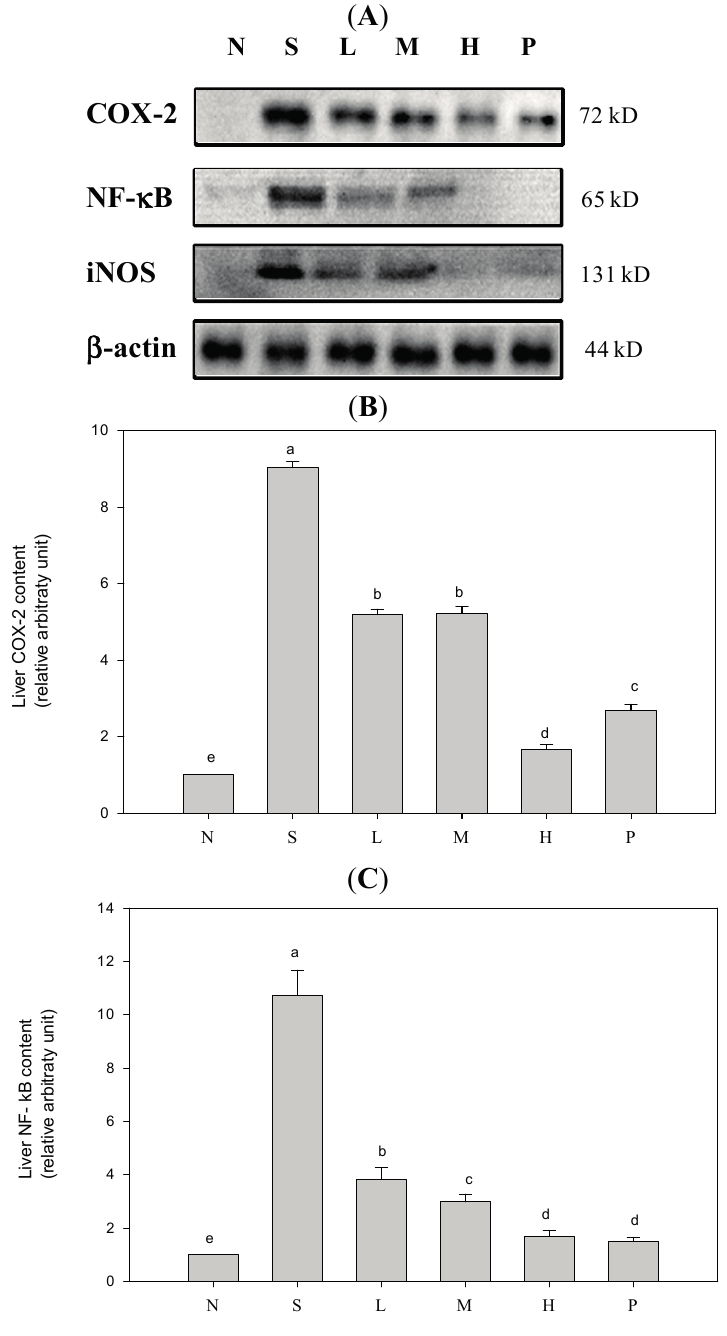
Figure 1. COX-2, NF- κ B, and iNOS inflammatory protein expression of LPS-induced sepsis mice. ( A ) The western blotting results of COX-2, NF- κ B, and iNOS. ( B ) The immunoblot quantitative result of COX-2 protein. ( C ) The immunoblot quantitative result of NF- κ B protein. ( D ) The immunoblot quantitative result of iNOS protein. Values are the mean ± SD of each group. Values not sharing a superscript (a–e) differ significantly by one-way ANOVA and Duncan’s Multiple Range Test ( p < 0.05) among groups. One representative immunoblot from three independent experiments is shown. N: Normal group, S: Sepsis group (i.p. LPS), L: Sepsis group with low-dose WBG, M: Sepsis group with moderate-dose WBG, H: Sepsis group with high-dose WBG, P: Positive control group (i.p.